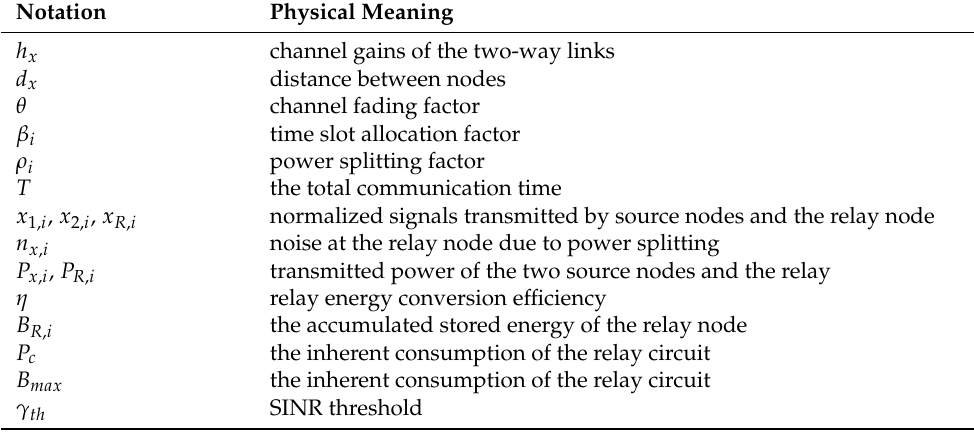
Figure 1. Schematic diagram of the SR-TWRS model under the TDBC transmission scheme. Table 2. Notation